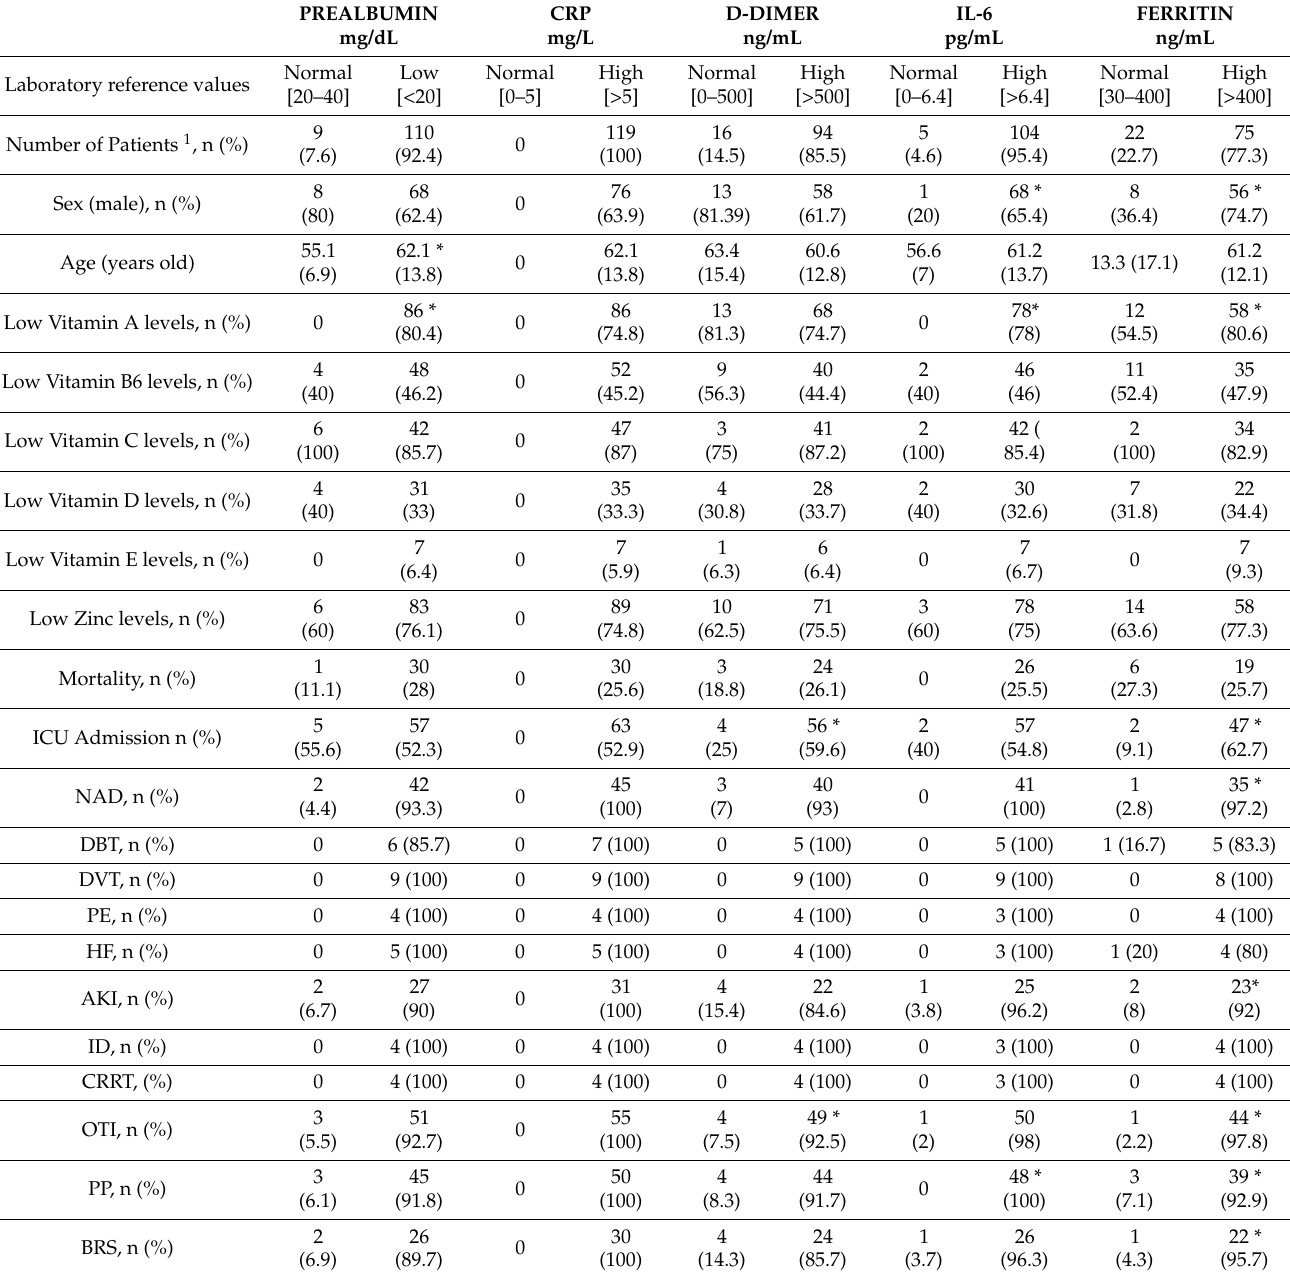
Table 3. Relevant data of the patients based on their inflammatory